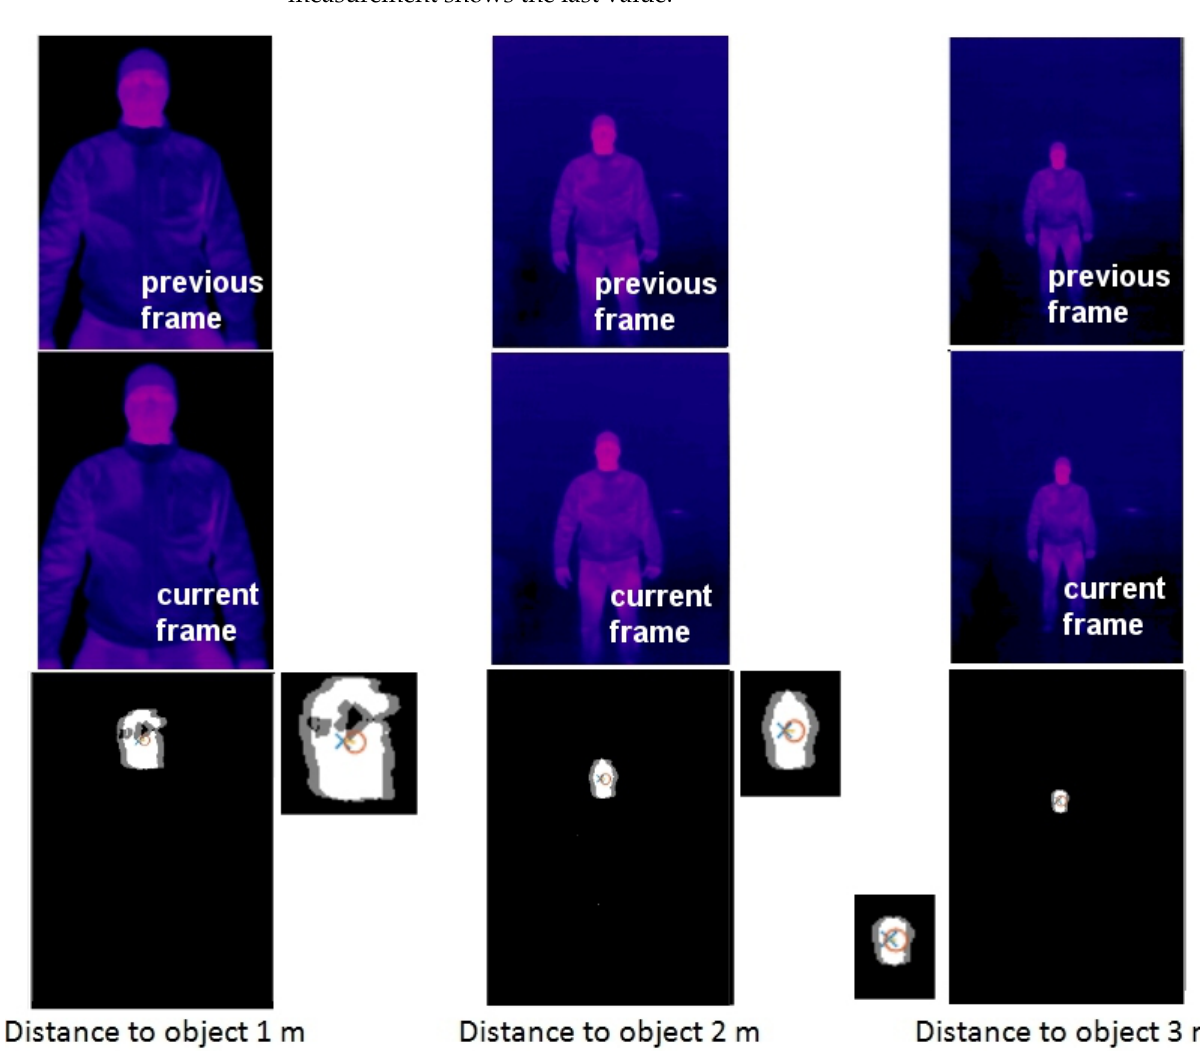
Figure 5. Selection of measured features determined in